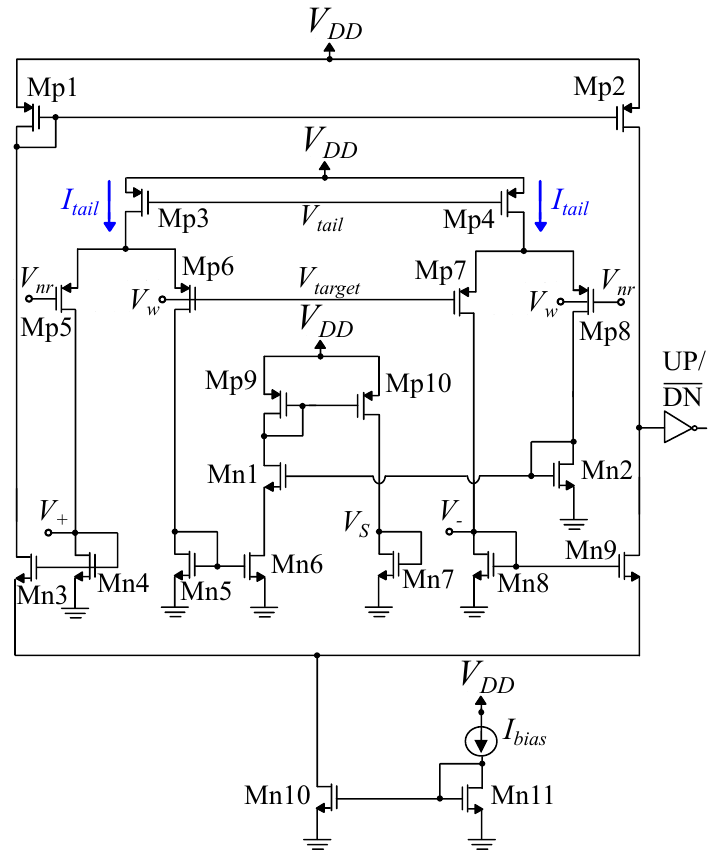
Figure 17. Transistor level implementation of the VWbump, which has electrical control over the Gaussian function curve’s